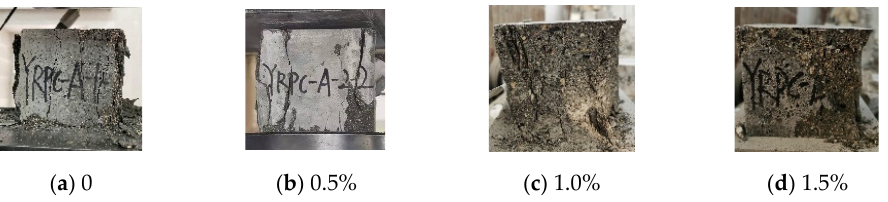
Figure 4. Compression failure modes of cubic specimens with different fiber contents at normal temperature.